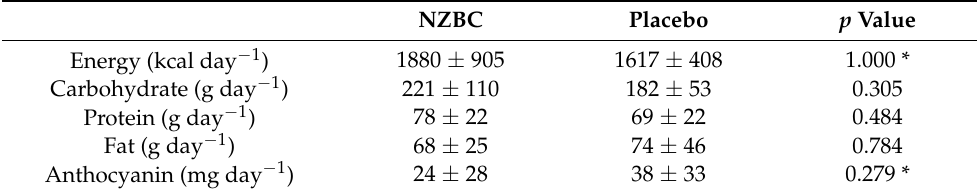
Table 2. Dietary analysis for NZBC ( n = 14) and PLA groups ( n =